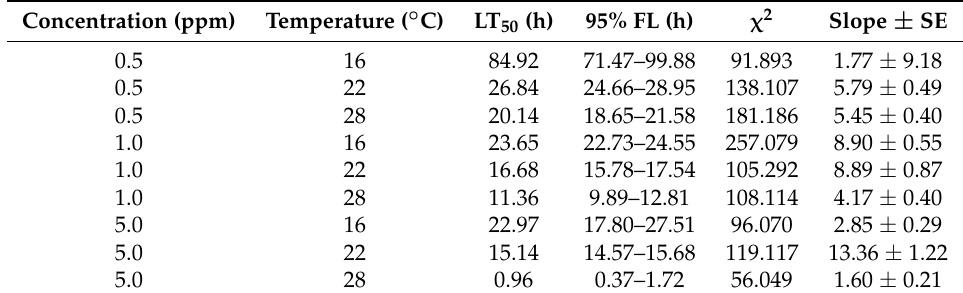
Table 1. Effect of concentration and temperature on mortality of eastern subterranean termites, R. flavipes , exposed to fipronil.